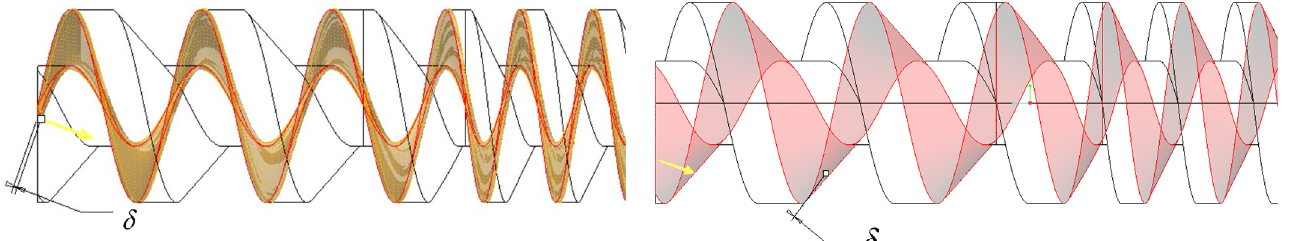
Fig. 4. Modi fi ed concave